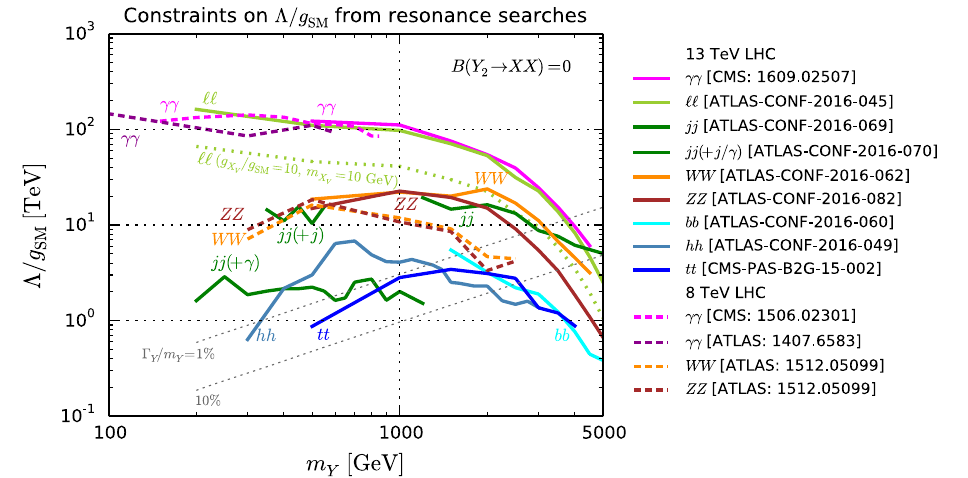
Fig. 9 Constraints on Λ/ g SM from observed 95% CL upper limits of resonance searches at the 13 TeV ( solid ) and 8 TeV ( dashed ) LHC as a functionofthespin-2mediatormass.Weassumeanegligiblebranching ratio to DM, except for a dotted line, where the vector DM coupling